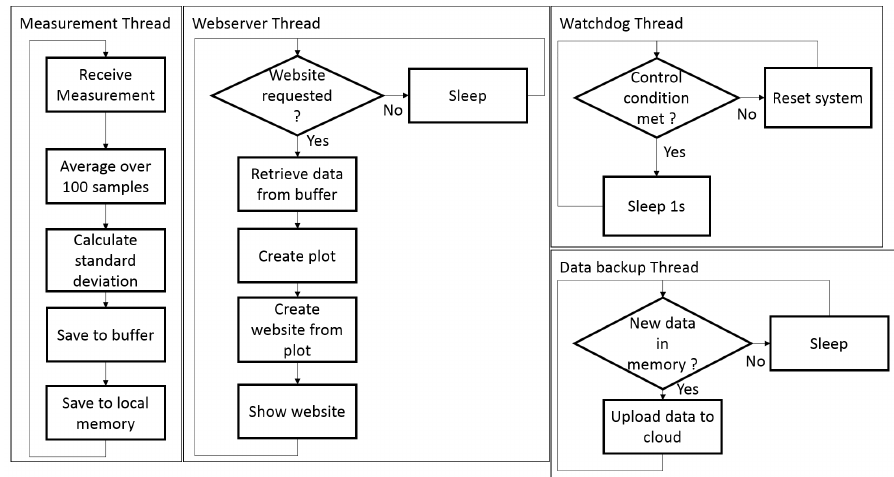
Figure 7. Flowgraph depicting the internal structure of the measurement system.